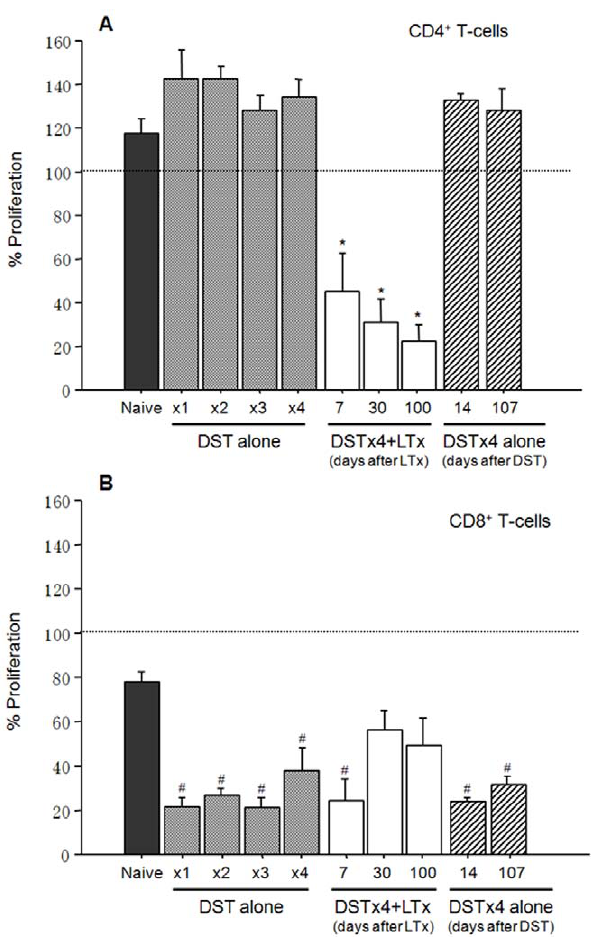
Figure 3. Suppressive activity of CD4 + or CD8 + T-cells from LEW rats subjected to DST alone or DSTx4 + LTx in vitro . (A) CD4 + T-cells (1 6 10 5 ) from rats subjected to one or more weekly DST treatments with or without LTx were incubated with donor (DA) irradiated splenocytes (2 6 10 5 ) in the presence of naı¨ve LEW T-cells (1 6 10 5 ) as described above. The dotted line shows the proliferation of T-cells from naı¨ve LEW rats (designated as 100%). DSTx4 alone at 14 and 107 days represent suppressive activity of CD4 + T-cells obtained from LEW rats pretreated with 4 weekly DST treatments and then harvested at 14 and 107 days following the last DST treatment. (B) CD8 + T-cells obtained from rats subjected to one or more weekly DST treatments with or without LTx were incubated with donor (DA) irradiated splenocytes (2 6 10 5 ) in the presence of naı¨ve LEW T-cells (1 6 10 5 ) as described above. The dotted line shows the proliferation of T-cells from naı¨ve LEW rats (designated as 100%). DSTx4 alone at 14 and 107 days represent suppressive activity of CD8 + T-cells obtained from LEW rats pretreated with 4 weekly DST treatments and then harvested at 14 and 107 days following the last DST treatment. Combined results are shown as mean 6 SE. * and # P , 0.05 compared with either CD4 + T-cells or CD8 + T-cells from naı¨ve LEW